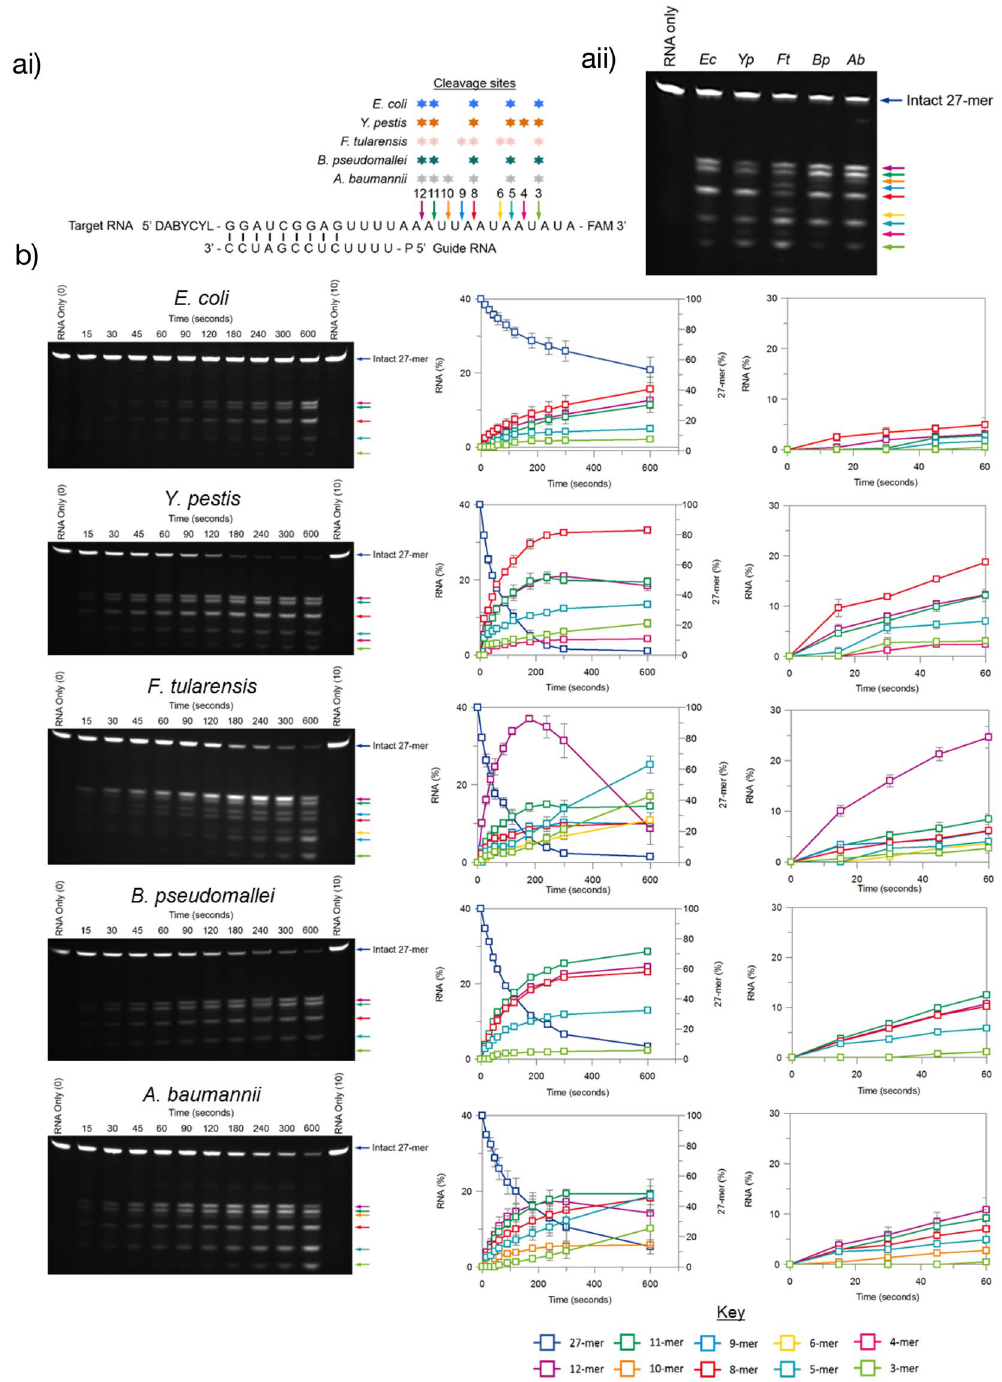
Figure 5. Cleavage site specificity of RNase E NTDs. ( ai ) Schematic of the target-guide RNA substrate. Coloured arrows indicate the position of cleavage sites that were observed for at least one of the RNase E NTDs, with the numbers above the arrows indicating the length of the 3 ′ FAM-labelled product that is produced by cleavage at that position. The cleavage sites that were observed for each homologue are indicated by stars above the respective position. ( aii ) 20% urea-PAGE analysis of cleavage of 1 μ M target-guide substrate by 5 nM E. coli , Y. pestis , F. tularensis , B. pseudomallei or A. baumannii RNase E NTD after incubation at 28 °C for 10 minutes. The gel was visualised using a G:Box UV transilluminator (Syngene). The gel in this figure has been cropped and the uncropped gel is presented in Supplementary Fig. S6a. The band corresponding to the FAM-labelled 27-mer component of the target-guide substrate is labelled and the coloured arrows to the right of the gel correspond to the FAM-labelled cleavage products described in ai. ( b ) 20% urea-PAGE analysis of cleavage of 1 μ M target- guide substrate by 5 nM E. coli , Y. pestis , F. tularensis , B. pseudomallei or A. baumannii RNase E NTD at 28 °C during a 10-minute time course. Gels were visualised using a G:Box UV transilluminator. The gels have